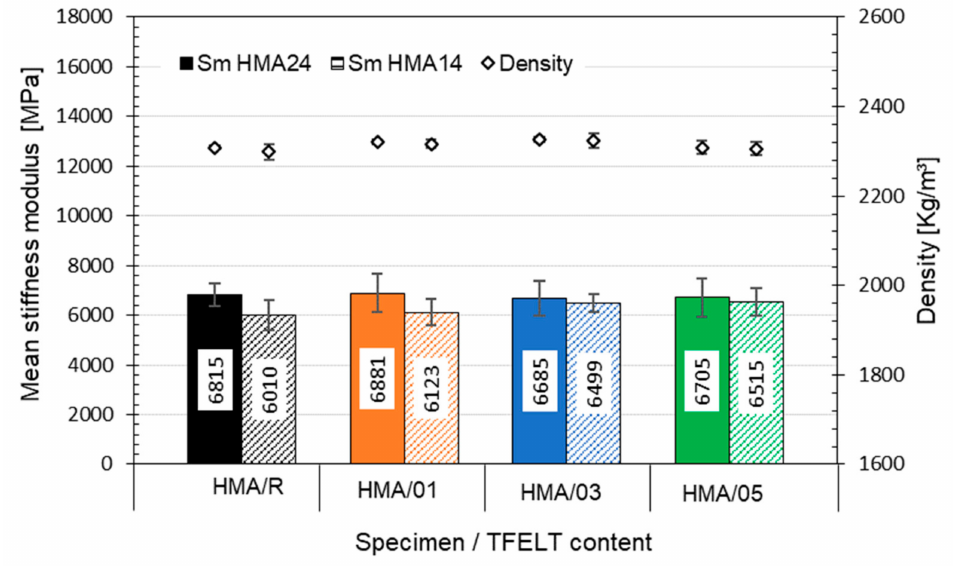
Figure 9. Hamburg results of stiffness modulus at 25 ◦ C for all the mixes